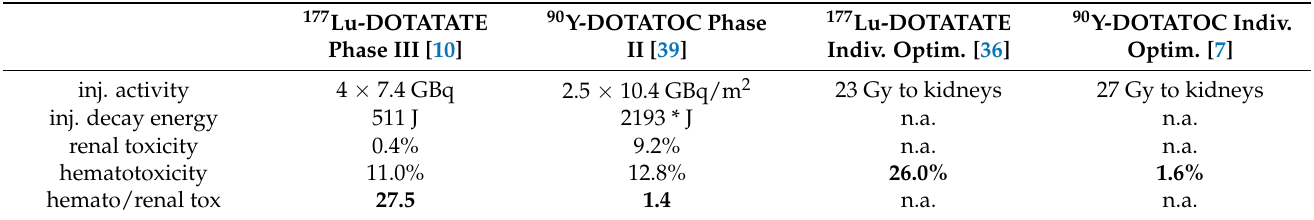
Table 2. Comparison of grade 3–4 toxicities between 177 Lu-DOTATATE and 90 Y-DODTATOC